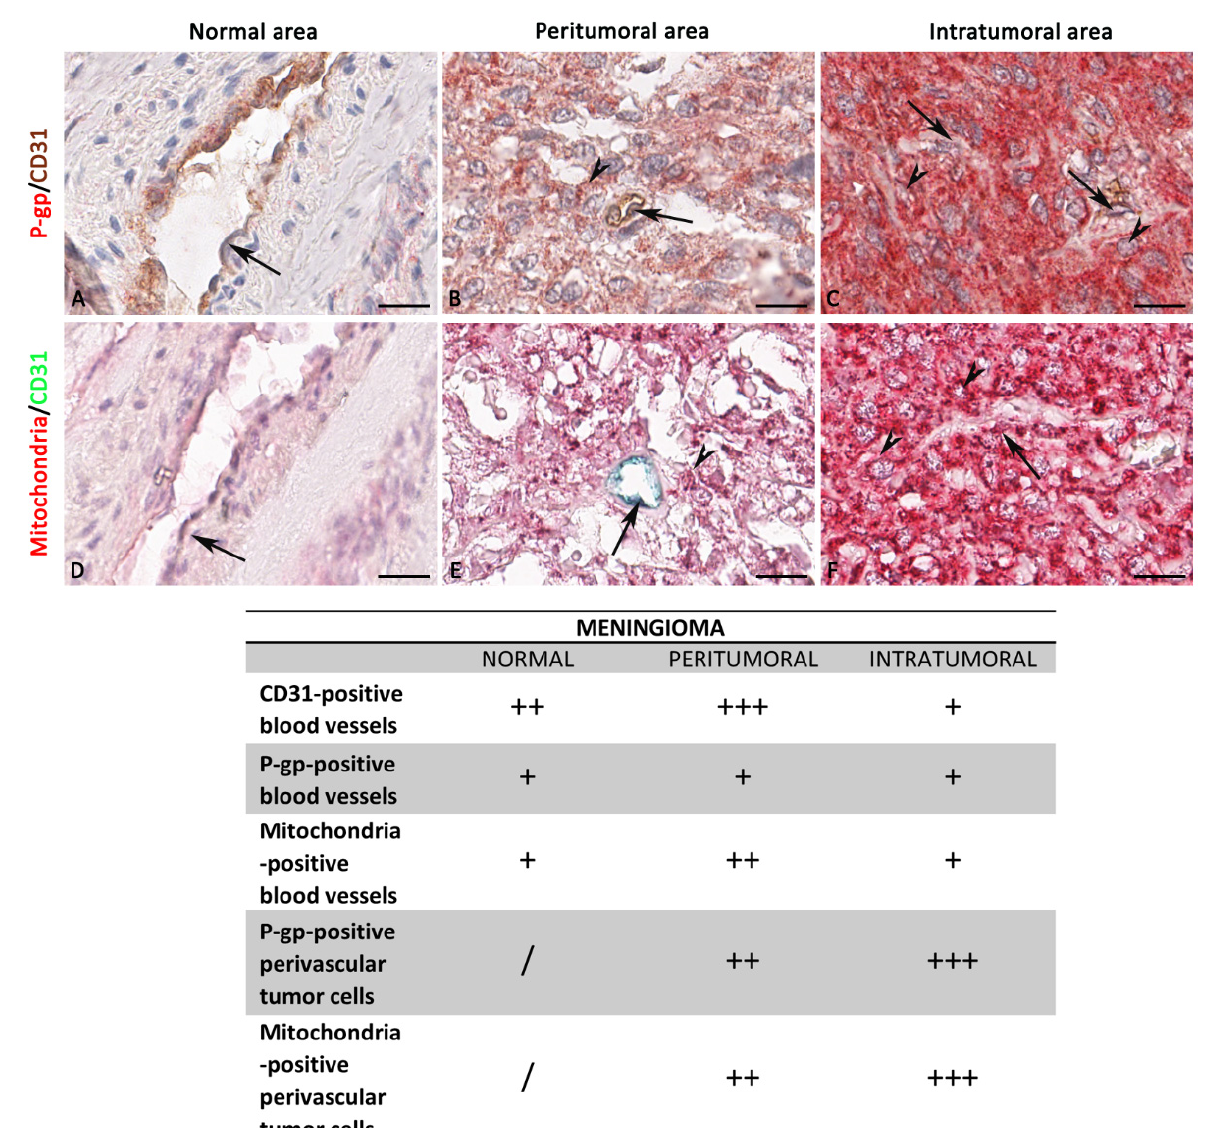
Figure 3. Focus on meningioma blood vessels and tumor cells. High magnification of P-gp, mitochondria, and CD31 immunohistochemistry reactions, within the same spatial ROIs on meningioma serial sections, and the summary table below show the differential expression of these markers by ECs and tumor cells. P-gp ( A – C ) and mitochondria ( D – F ) expression by tumor cells progressively increase from normal to intratumoral areas. Mitochondria + CD31-positive ECs show a higher proliferative profile in the peritumoral area ( E ), while there are no relevant differences in Pg-P expression. CD31 expression is reduced in the intratumoral areas ( C , F ) compared with the others. The table shows the semi-quantitative scoring of IHC reactivity: “/”, very weak or absent; “+”, weak; “++”, intermediate; “+++”, strong. Arrows: ECs; arrowheads: tumor cells. Scale bar: ( A – F ) 16 µ m.